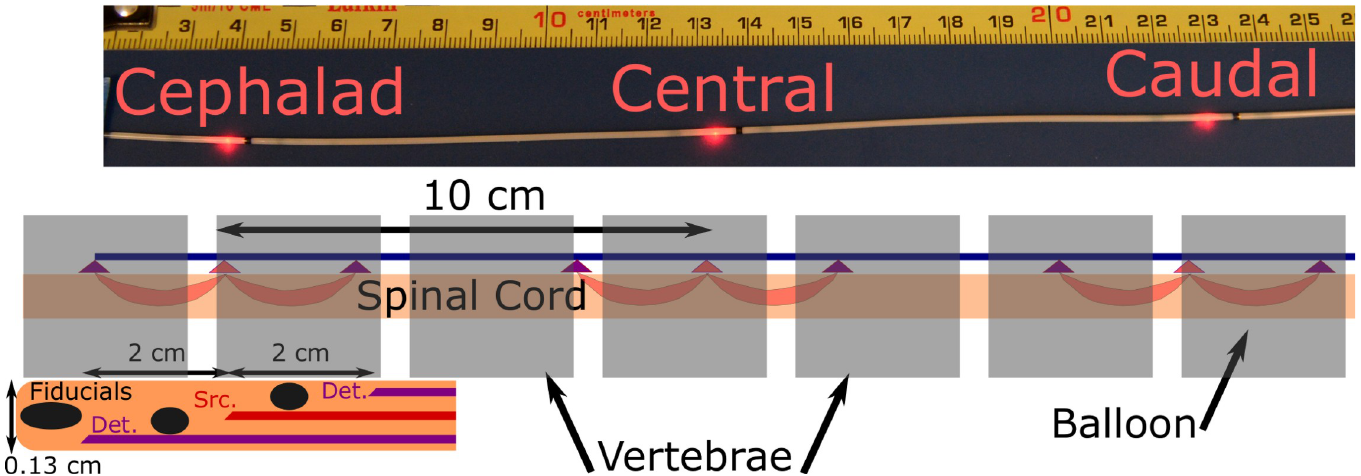
Fig 1. Photo of 3 position probe, all three source fibers illuminated. Black regions of probe are combined radiographic fiducials and blocks to prevent light propagation down the length of the probe. Schematic of probe in spine and expanded view of probe distal tip, showing fiducials at tip and between each source-detector pair, as well as the fiber positions. Each of the three detector-source-detector combinations along the probe is configured in a similar fashion. Not to scale.